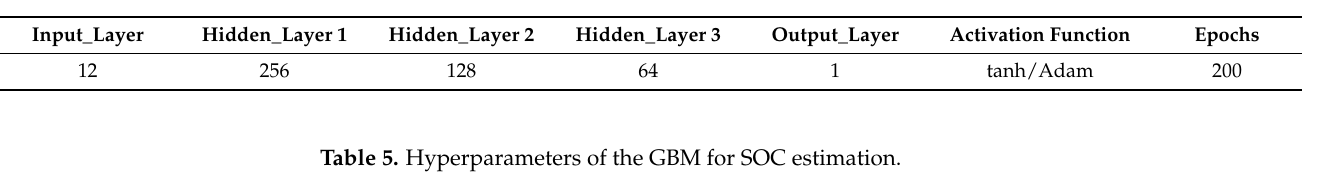
Table 4. Hyperparameters of the GRU for SOC estimation.